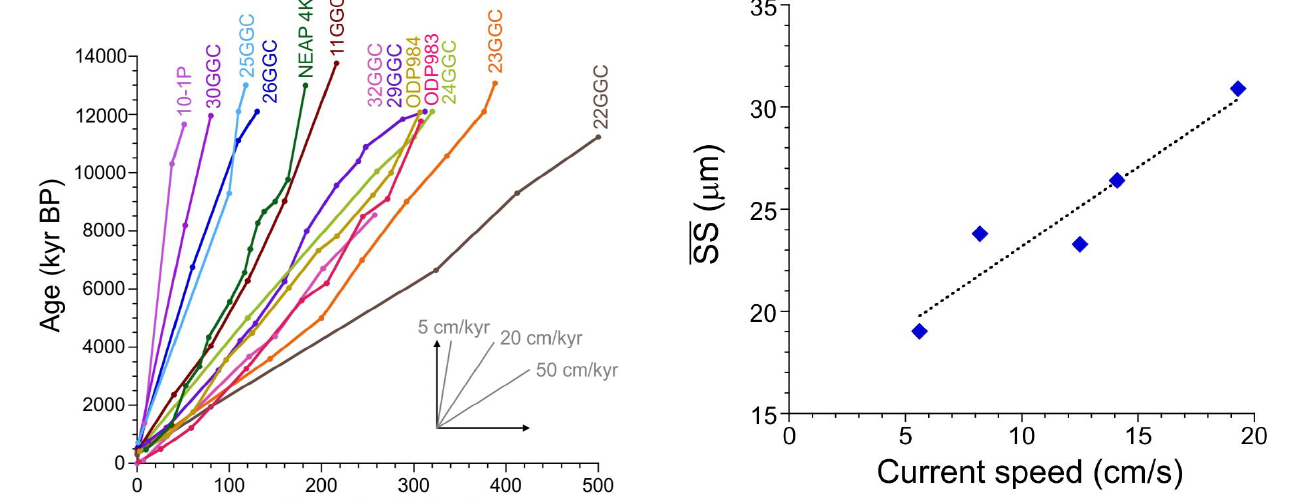
Fig. 3. Core-top SS calibration for the northern Iceland Basin; SS = 15 . 4µm+0.78 U , where U is mean current speed (in cms − 1 ) ( R 2 = 0 . 89, n = 5, p = 0 .